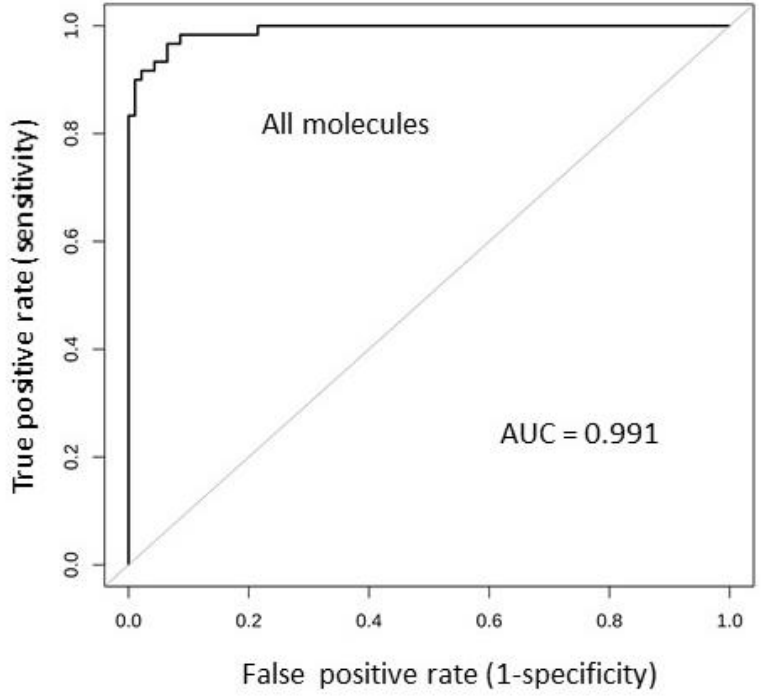
Figure 7. ROC analysis of the SVM-based model, classifying the melanoma samples against the controls.